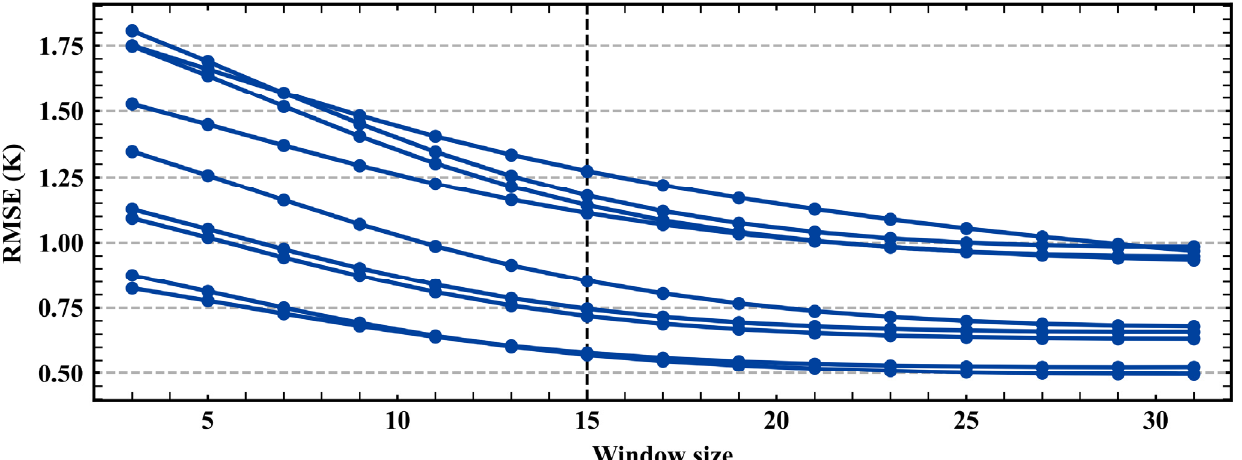
Figure 5. Line plots of the RMSEs of true coarse-resolution spatial feature images and aggregated coarse-resolution spatial feature images. The aggregated coarse-resolution spatial feature images are aggregated from fine-resolution spatial feature images calculated from different window sizes.